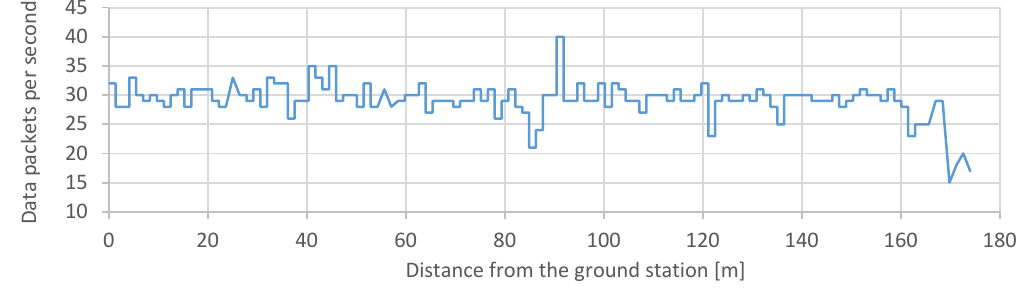
Figure 26. Wi-Fi telemetry system maximum operating range test [5].